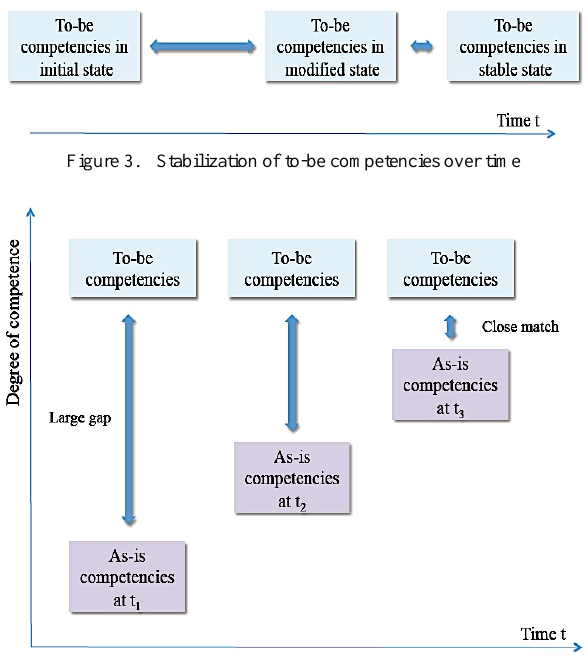
Figure 4. Convergence of intra-group as-is competencies against to-be